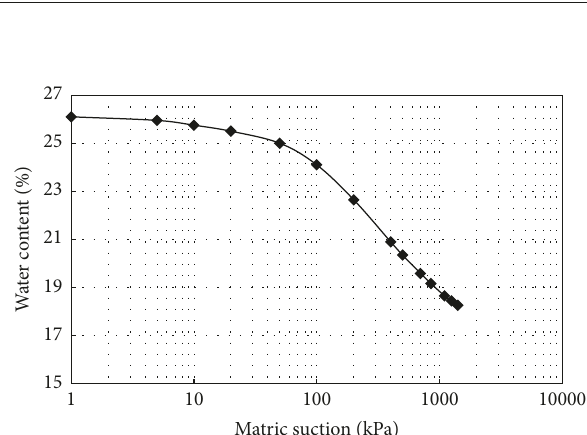
Figure 4: The soil water characteristic curve of soil treated by the